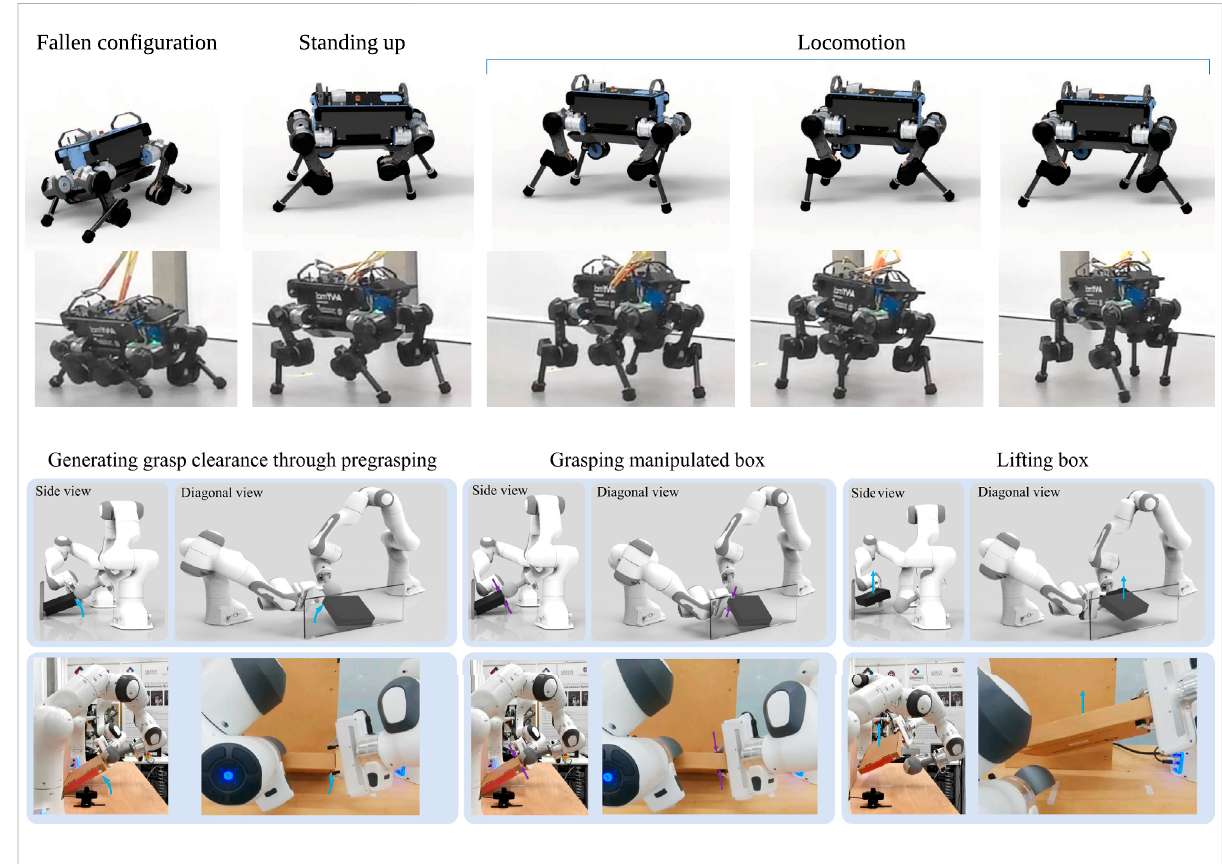
FIGURE 11 Multi-expertpoliciesinsimulationandontherealrobot.Top:Robustlocomotionofgaitrecoveryfromapronepositionandsmoothtransitions to trotting. Bottom: Dual-arm cooperative manipulation and